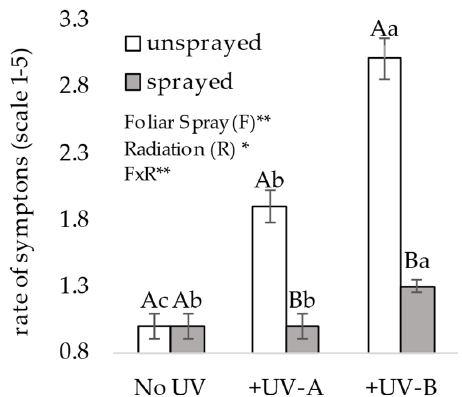
Figure 3. Effect of UVR regimen and/or mitigating treatments on the level of symptoms observed on the morphology of leaflets. The same uppercase letters within sprayed/unsprayed (intra-treatment) or the same lowercase letters across UVR regimens (inter-treatment) indicate no difference using Tukey’s test ( p < 0.05). * and ** denote significance among foliar spray and UV radiation, according to the Tukey test (ANOVA).